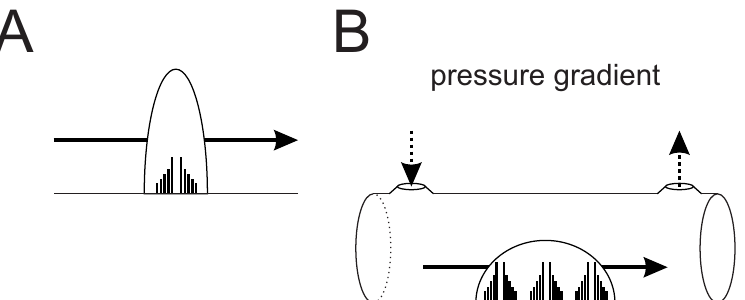
Figure 1. Scheme of the lateral line system. ( A ) Superficial neuromasts (SNs) are located on the skin of the animal and are sensitive to flow velocity; ( B ) canal neuromasts (CNs) are located in subepidermal canals. They are sensitive to fluid motion inside the canal caused by pressure gradients between adjacent canal pores. Solid-lined arrows indicate fluid motion; dashed-lined arrows indicate pressure acting on the pores. Modified from